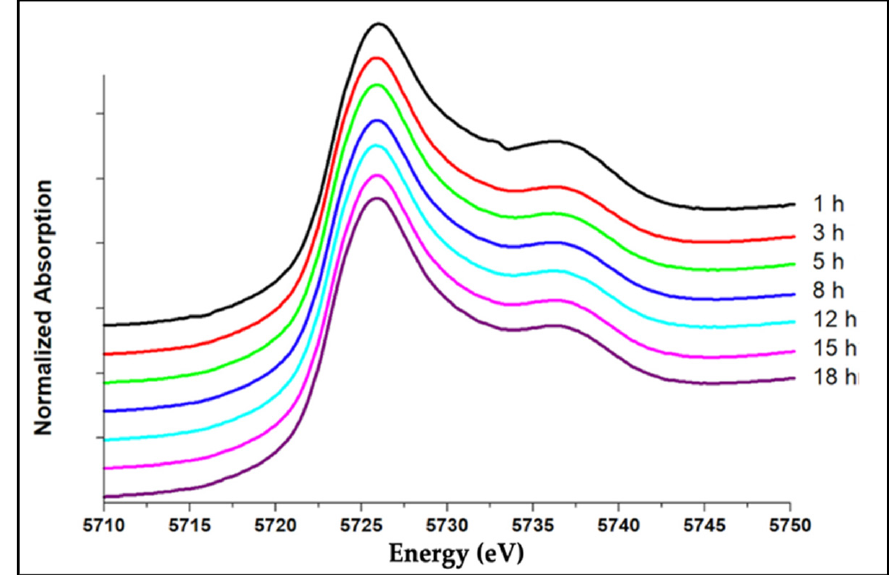
Figure 2. XANES spectrum for S5NBCe glass melted for different hours at 1100 °C .